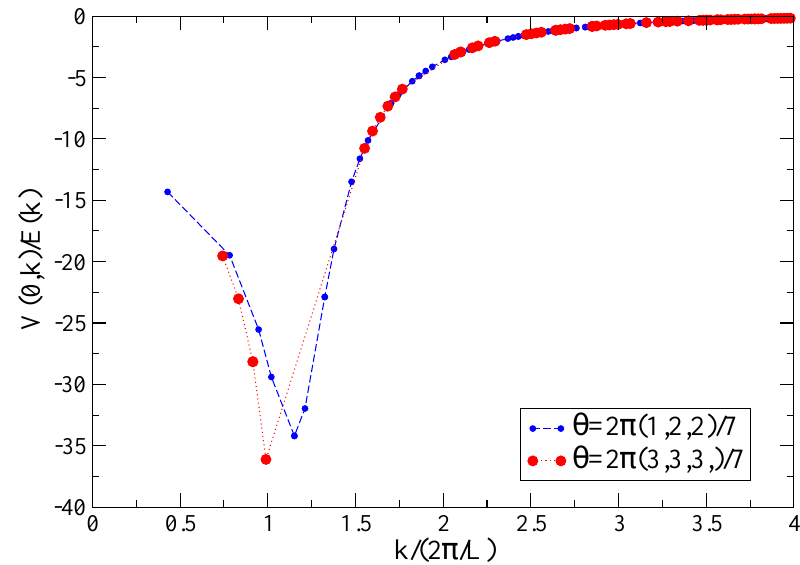
Figure 7. The kernel of the gap equation for edge and non-edge